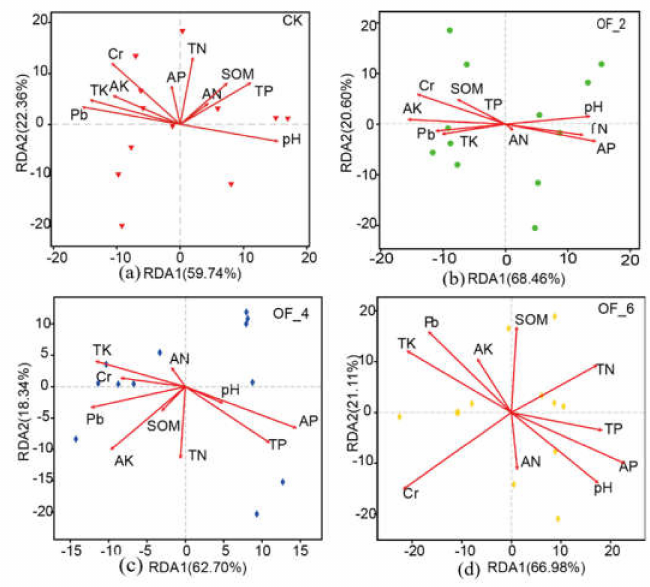
Figure 10. Correlations between soil properties and the community structure of soil bacterial as determined by redundancy analysis (RDA) during the entire maize growth cycle. ( a ) seedling stage; ( b ) Three-leaf stage; ( c ) filling stage; ( d ) mature